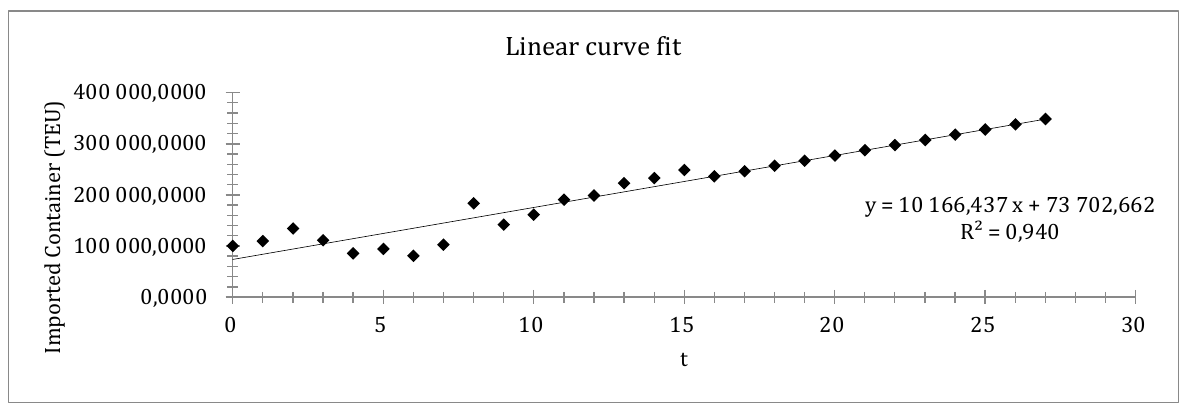
Figure 2: Linear curve fit for the trend analysis for imported container traffic in Nigeria (1999-2017)